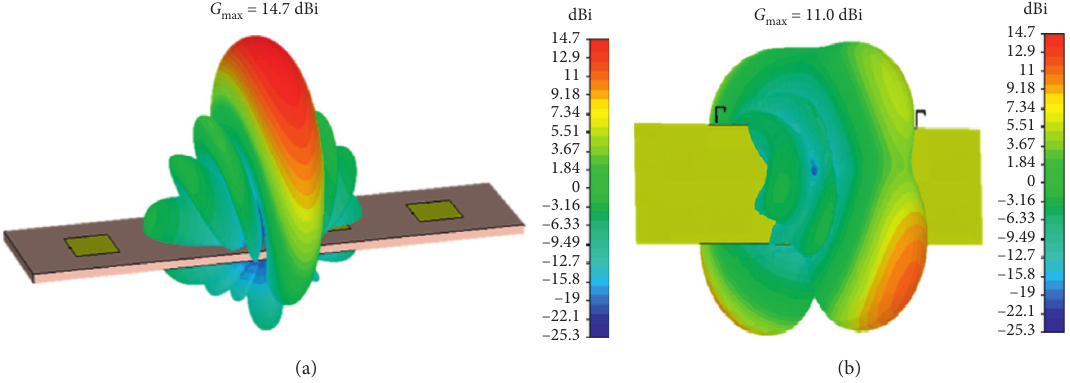
Figure 1: Antenna array radiation patterns for ψ � 90 ° : (a) PBS; (b) MBS.